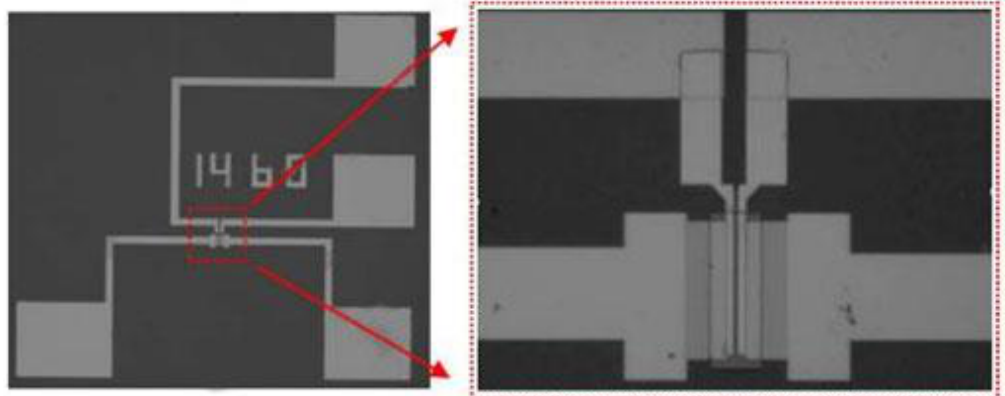
Figure 11. Optical photographs of the top gate FET device.